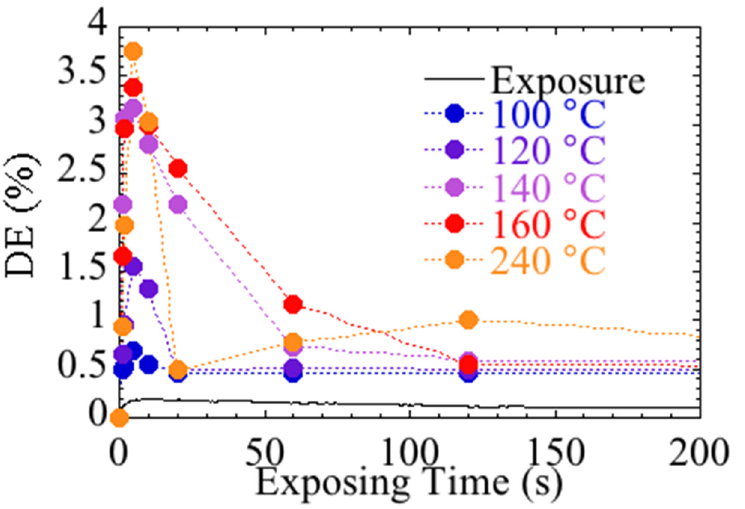
Figure 3. Variation in +1st diffraction efficiency of P1 film as a function of exposure time (solid line) and 1st diffraction efficiency of P1 film after thermal annealing under various temperatures (dashed lines).